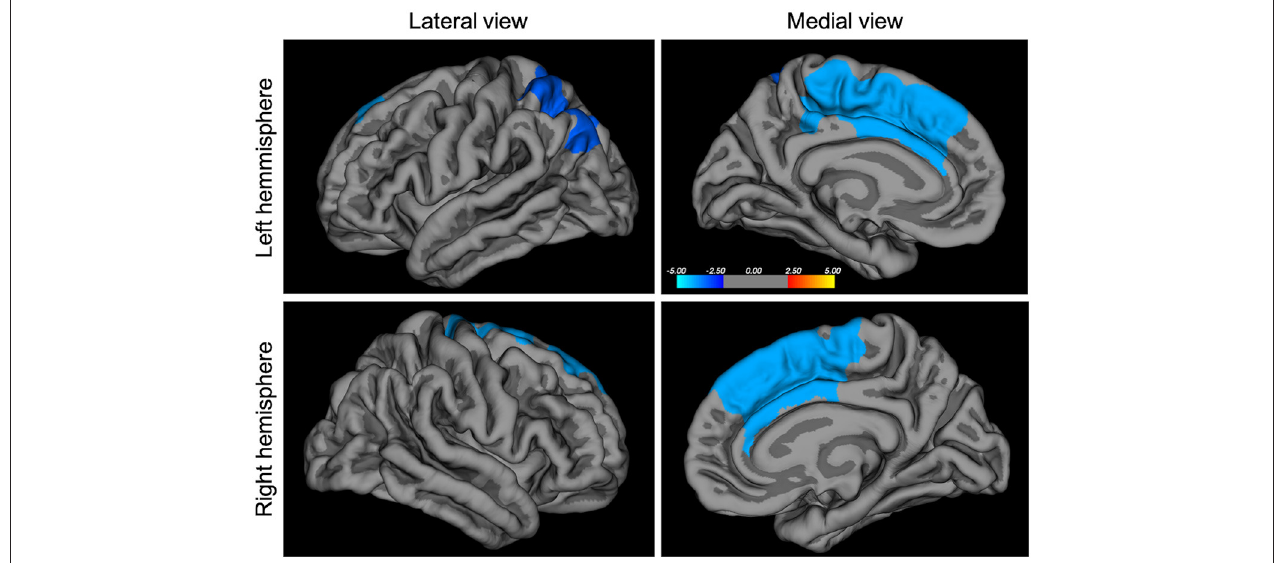
FIGURE 2 | Negative correlation between SCARED-parents score and local gyrification index, p < 0.05 corrected, N = 590. SCARED, Screen for Child Anxiety Related Emotional Disorders. The colors represent the –log 10 ( p -value at cluster level) with red indicating a positive correlation and blue indicating a negative correlation between scores and morphological features.